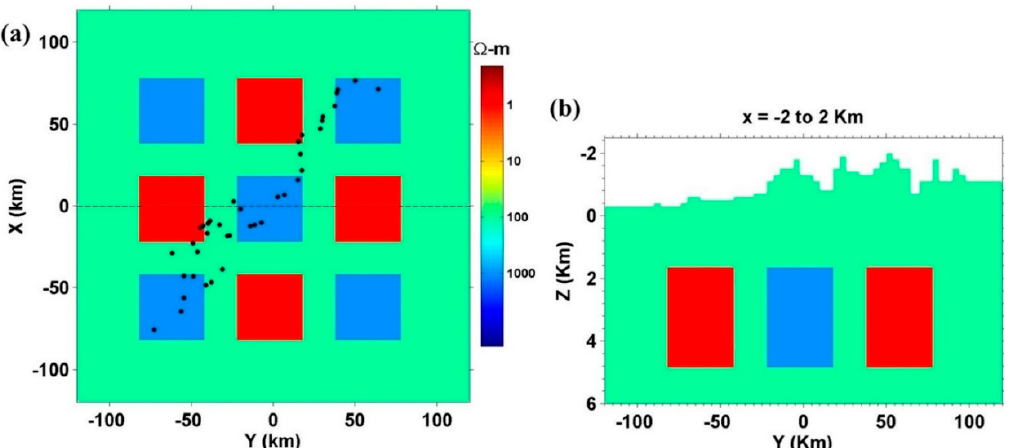
Figure 6. 3D synthetic model with real topography of the GHC region: ( a ) XY section and ( b ) YZ section. The model contains 9 anomalous bodies of dimensions 40 km × 40 km × 2.5 km. In total, 39 MT sites of the RG profile were placed at their real location and elevation in the model.